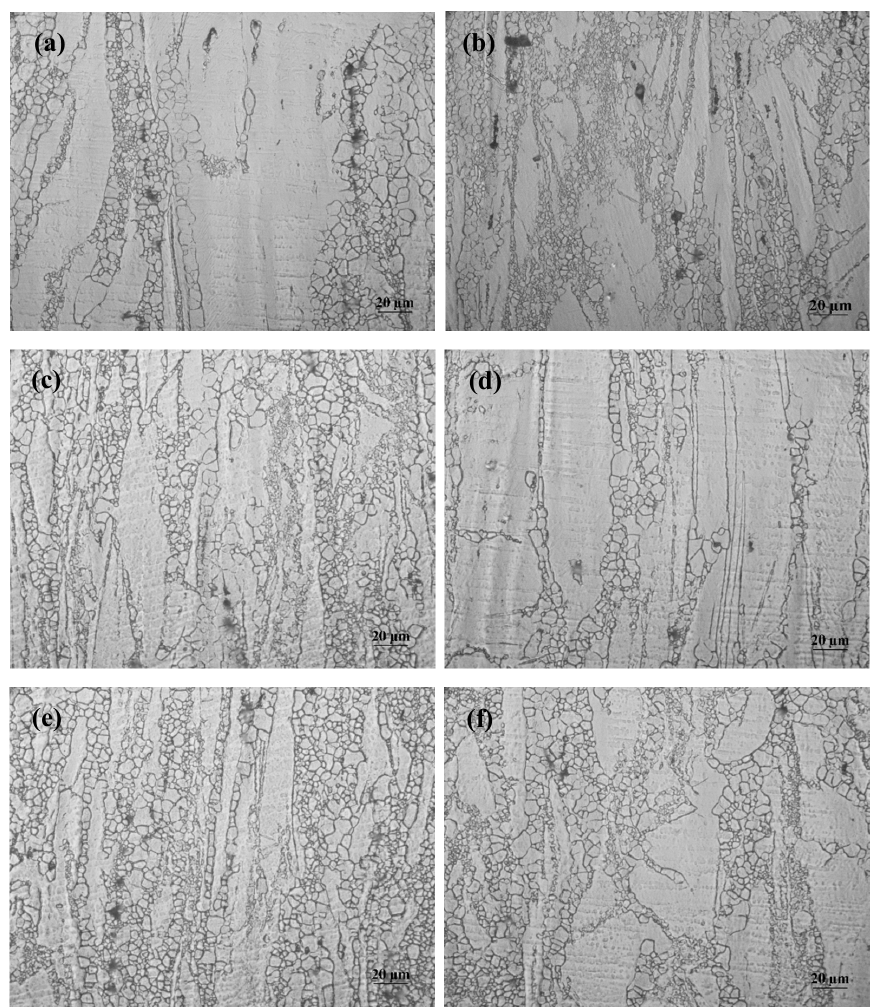
Figure 3. Microstructures of AZ31 ( a , c , e ) and AZ31-1%CaO alloy ( b , d , f ) at different extrusion ratios under 300 ◦ C. ( a , b ) extrusion ratio is 3; ( c , d ) extrusion ratio is 6; and, ( e , f ) extrusion ratio is